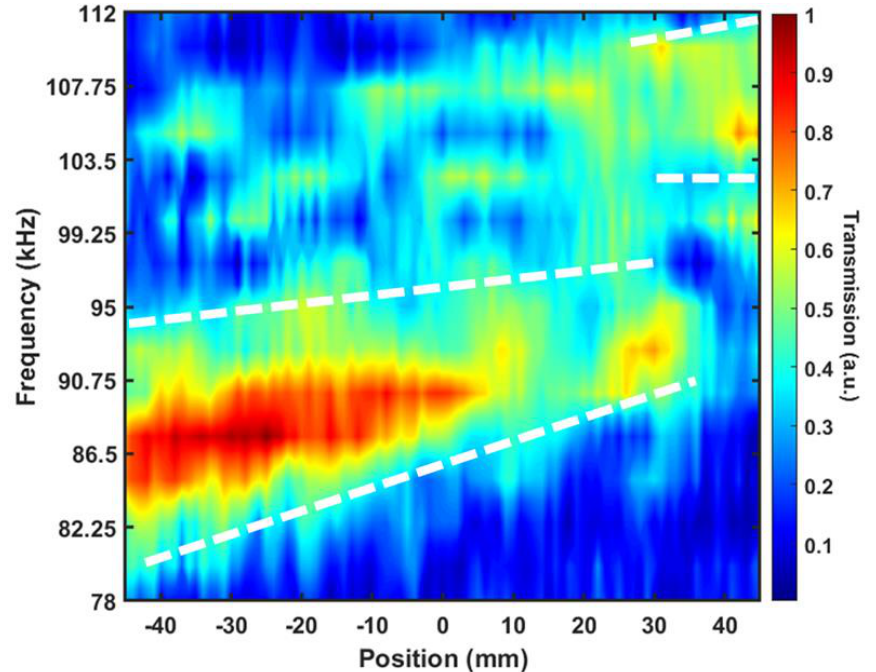
Figure 5. Experimental result of superlattice decomposition performance of the entire second transmission band along the scanned line at 2 mm parallel to the last layer of the superlattice. At different locations along the vertical axis, transmission peaks centered at different frequencies are observed. The 10-layer superlattice decomposes the pulse into narrow bands propagated along different refraction paths that finally arrive at different locations on the scanned line.